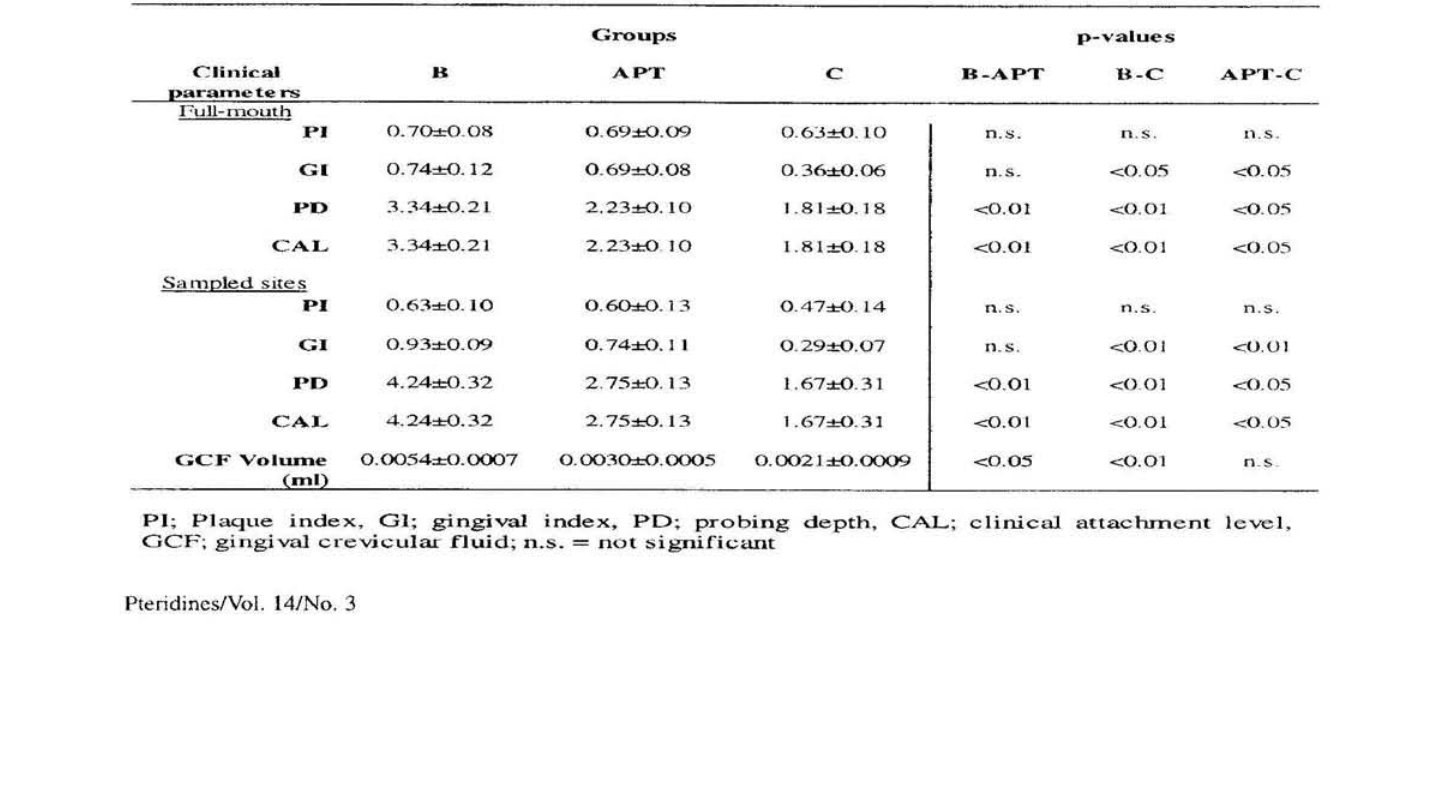
Table 1. Clinical parameters and GCF volumes of the control group (C) and the aggressive at the baseline (B) and after the periodontal treatment (APT) (Mean ±